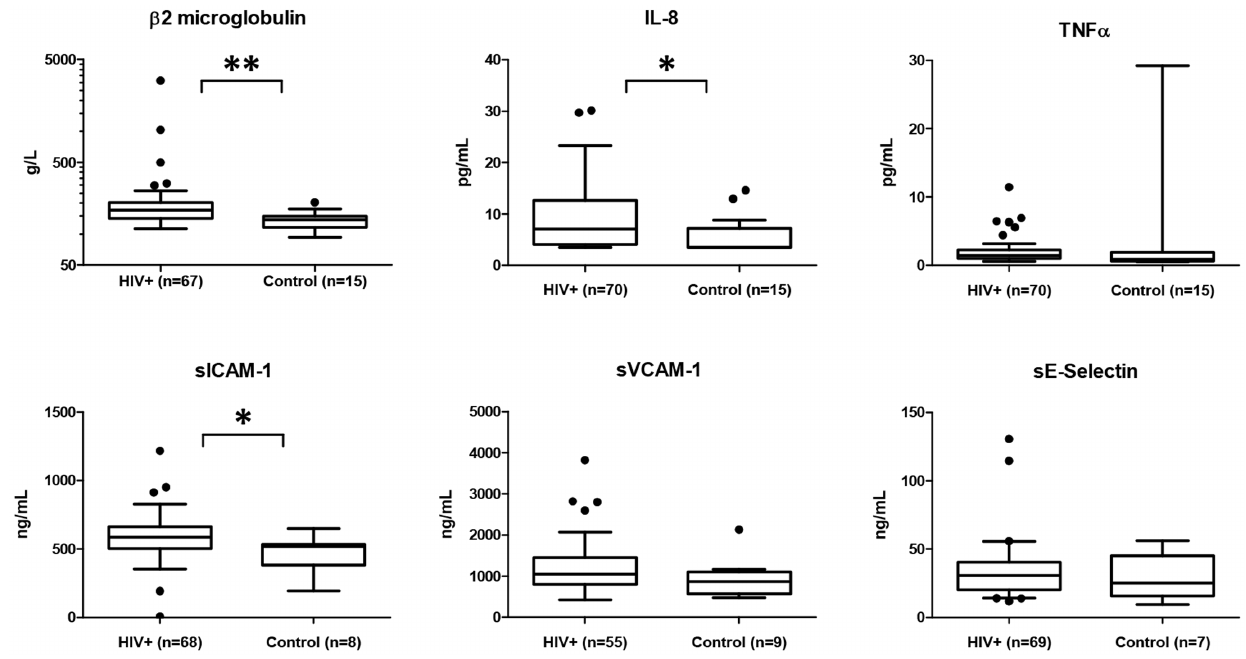
Figure 1. Levels of b 2-microglobulin, IL-8, TNF a , sICAM-1, sVCAM-1 and sE-Selectin in HIV infected patients (HIV + ) after 12 years of successful cART compared to HIV negative controls. Please note that b 2-microglobulin is shown on a logarithmic Y-axis. Means were compared using Mann-Whitney test and depicted as boxplots with Tukey whiskers (1.5 times the interquartile distance or to the highest or lowest point, whichever is shorter). *=p , 0.05, **=p , 0.001.